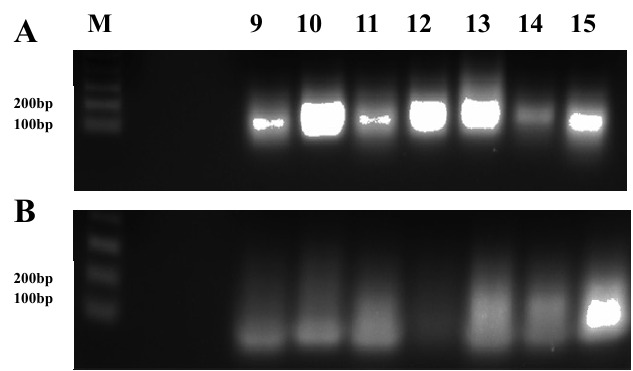
Figure 2. Real-time polymerase chain reaction (RT-PCR) analysis of transformed Vero cells. The presence of a 130 bp fragment (t-RNA val promoter + ribozyme) for each ribozyme ( A ) demonstrates stable transformation of the clonal cells. The absence of this 130 bp fragment in the RT-negative control ( B ) indicates a lack of genomic DNA contamination in the isolated RNA. The low molecular weight smears apparent in each lane are attributed to primer dimers as they are well below the lowest size standard in the gel. The forward primer used was specific to the common t-RNA val promoter, and the reverse primer was specific for each ribozyme. M = 1 kb plus DNA ladder, lanes 9–15 correspond to hRzs #9 through #15.